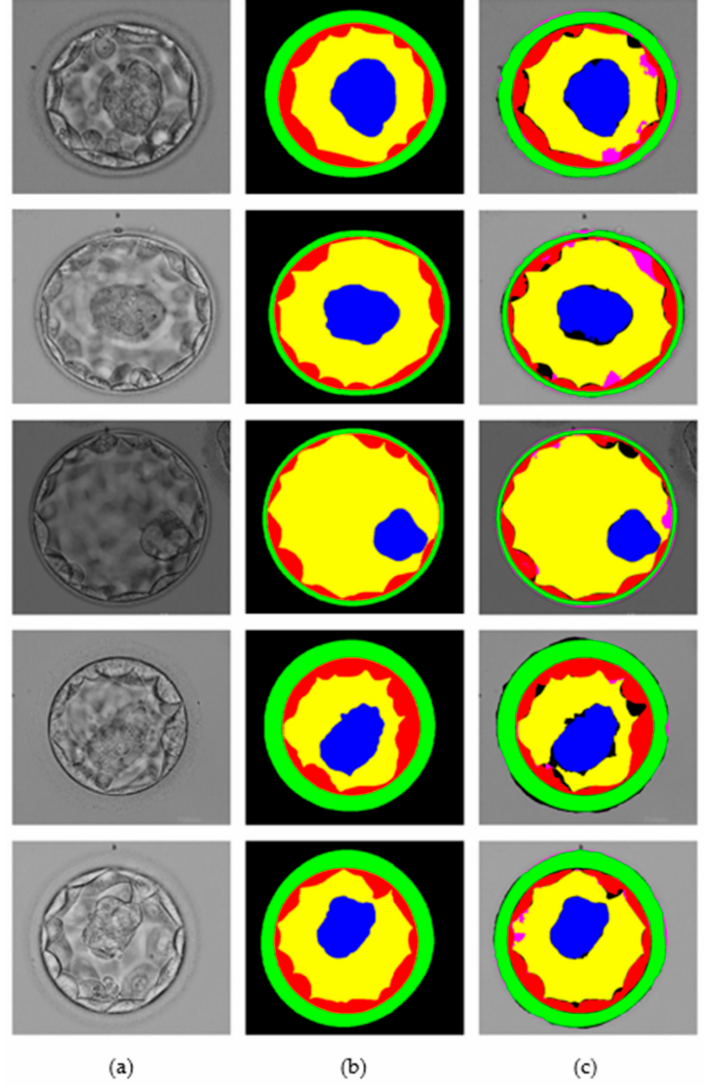
Figure 6. MASS-Net visual results for embryo component segmentation: ( a ) input microscopic blastocyst image, ( b ) expert annotation, and ( c ) MASS-Net multiclass predicted